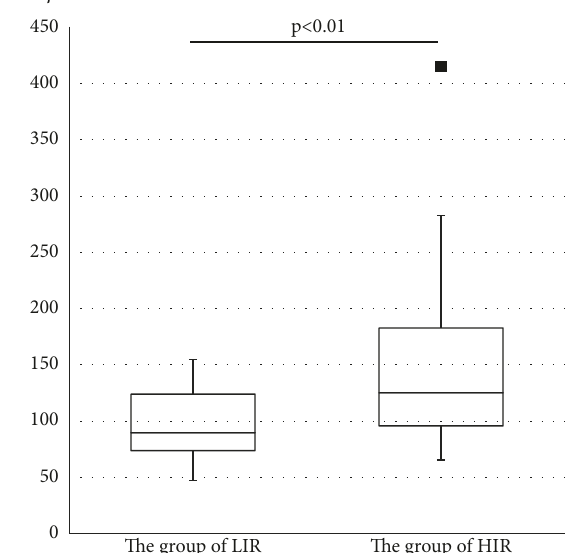
Figure 4: Comparison of HOMA- 𝛽 between the LIR and HIL groups. LIR group: women with low insulin resistance, HIR group: women with high insulin resistance. HOMA- 𝛽 : Homeostasis model assessment of 𝛽 -cell function. Comparison between groups was made using Welch’s t test. The black bar represents the median. The interquartilerange is representedby a box. Values exceeding 1.5 IQR were represented by closed squares. The HOMA- 𝛽 of the LIR group is significantly lower than that of the HIR group.